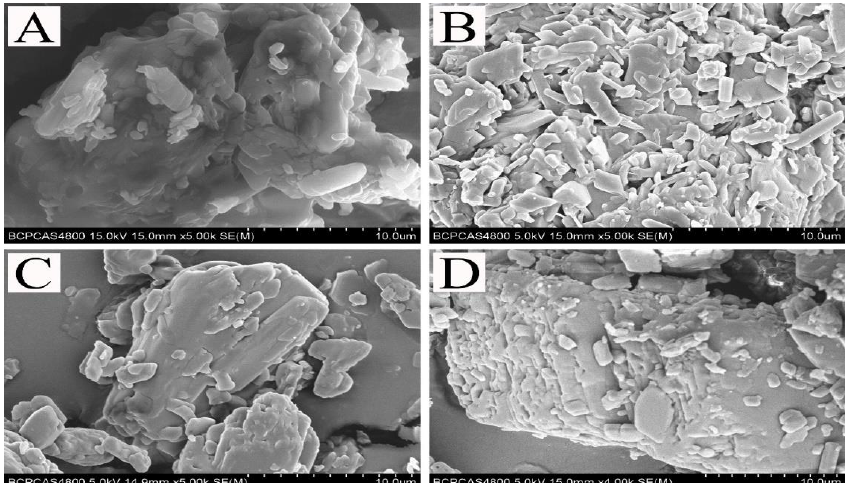
Figure 3. SEM images of the two pyraclostrobin crystals with or without adsorbed dispersant 2700. ( A ) pyraclostrobin crystal II, ( B ) pyraclostrobin crystal II +2700, ( C ) pyraclostrobin crystal IV, ( D ) pyraclostrobin crystal IV +2700.